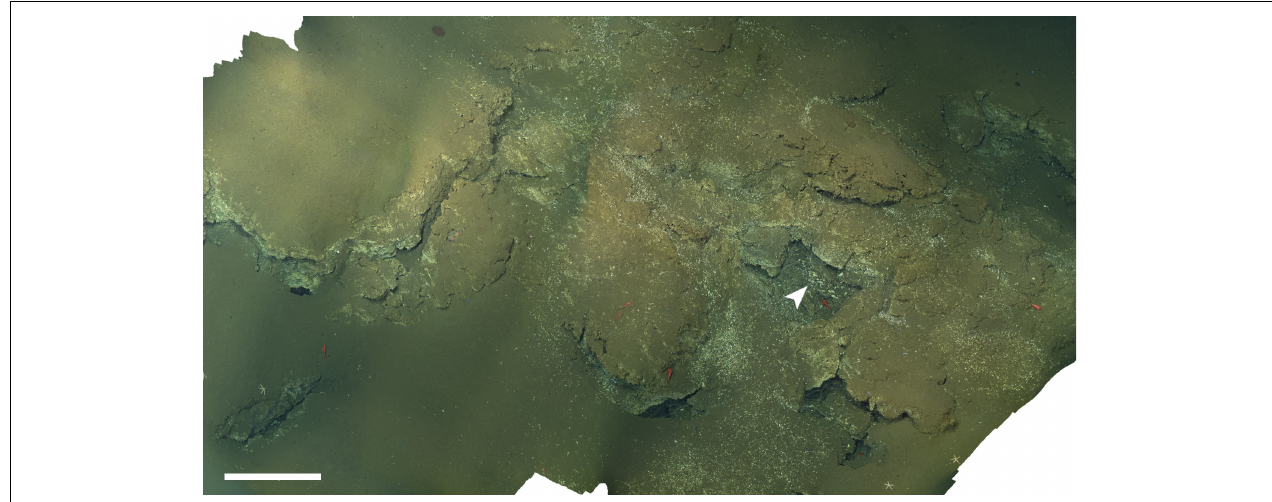
FIGURE 3 | Video-mosaic of a section of Fossil Hill (area shown in Figure 1C ). White arrow head shows locations of the depression with overhang figured in more detail in Figure 4E , scale bar is approximately 2